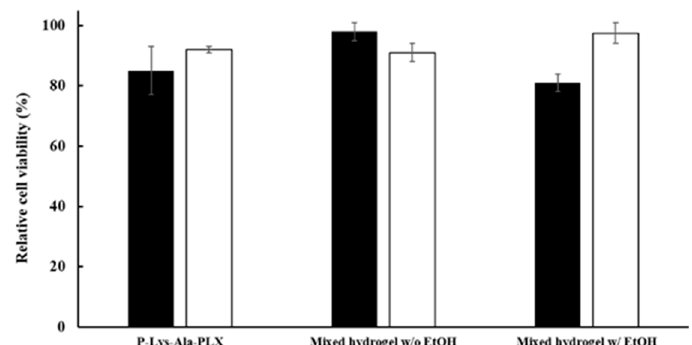
Figure 7. Cytotoxicity of conditioned mediums of various formulations by the MTT assay. Mixed hydrogels: 5:1 P–Lys–Ala–PLX to Pluronic F-127. Ethanol was added to the gel as in the 10 mg/mL formulation but without the drug. The black bar was on day 3 (black) and the white bar was on day 7.